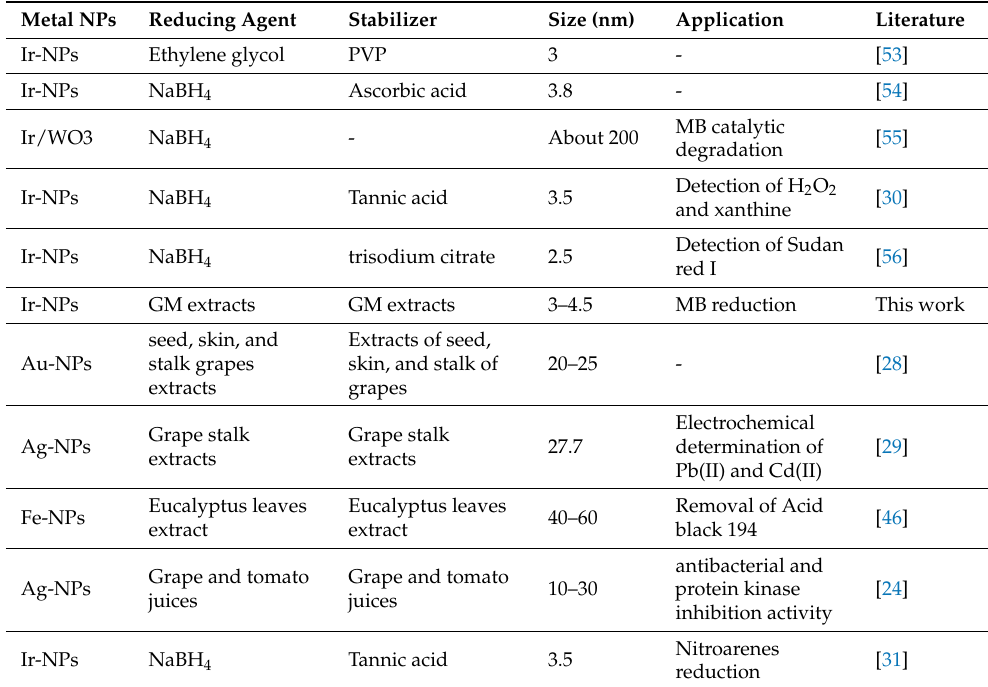
Table 4. Comparison of catalytic results for MB degradation with literary